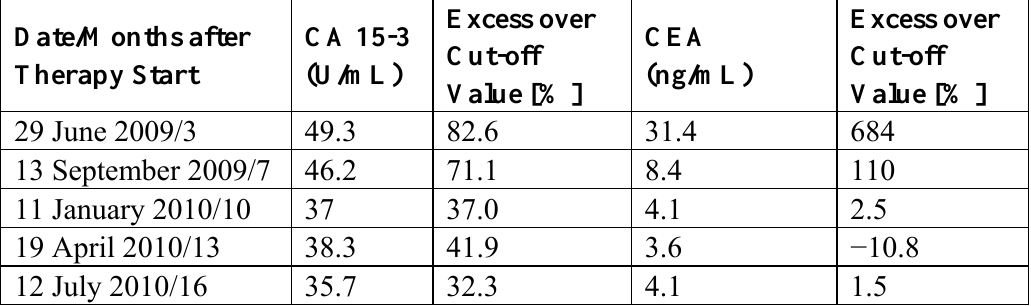
Table 1. Development of the CEA and CA 15-3 serum concentrations over time; cut-off values were 4 ng/mL for CEA and 27 U/mL for